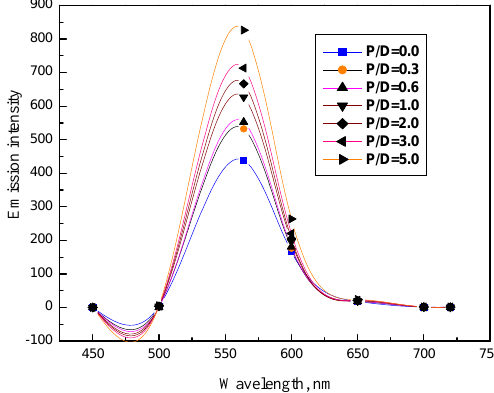
Figure 15. Emission spectra of AO-NaCar system at various P/D ratios